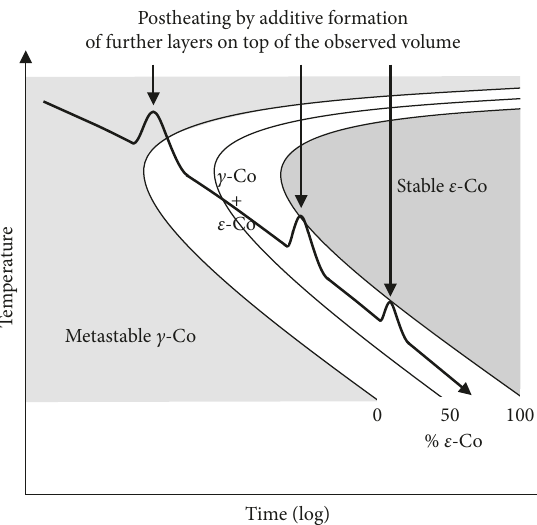
Figure 12: Continuous TTT diagram schematically, adapted from